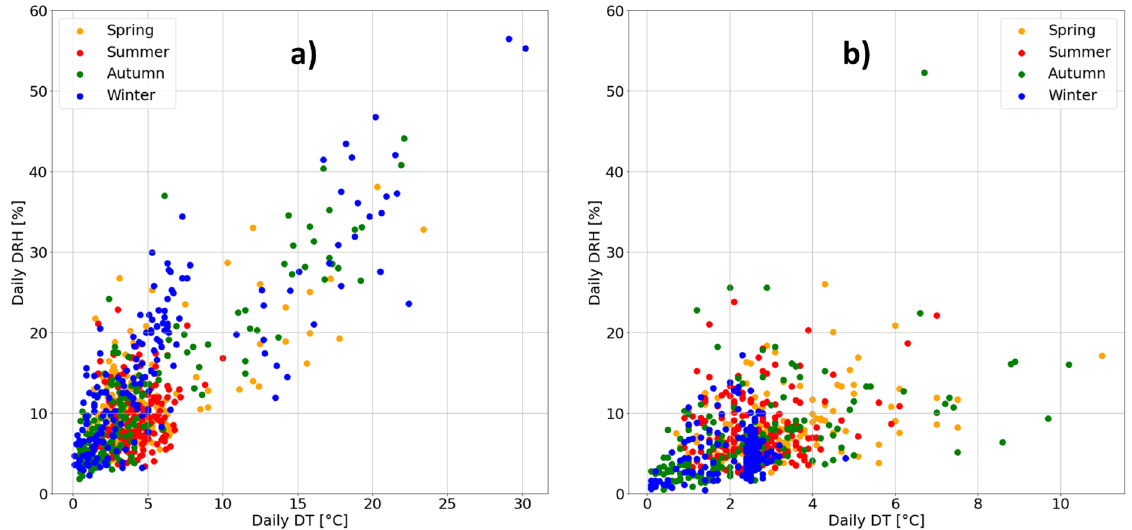
Figure 4. Scatter map of daily range of RH vs. daily range of T for Ringebu church ( a ) and Heddal church ( b ). The different colours stand for the different seasons of the calendar year, according to the legend.